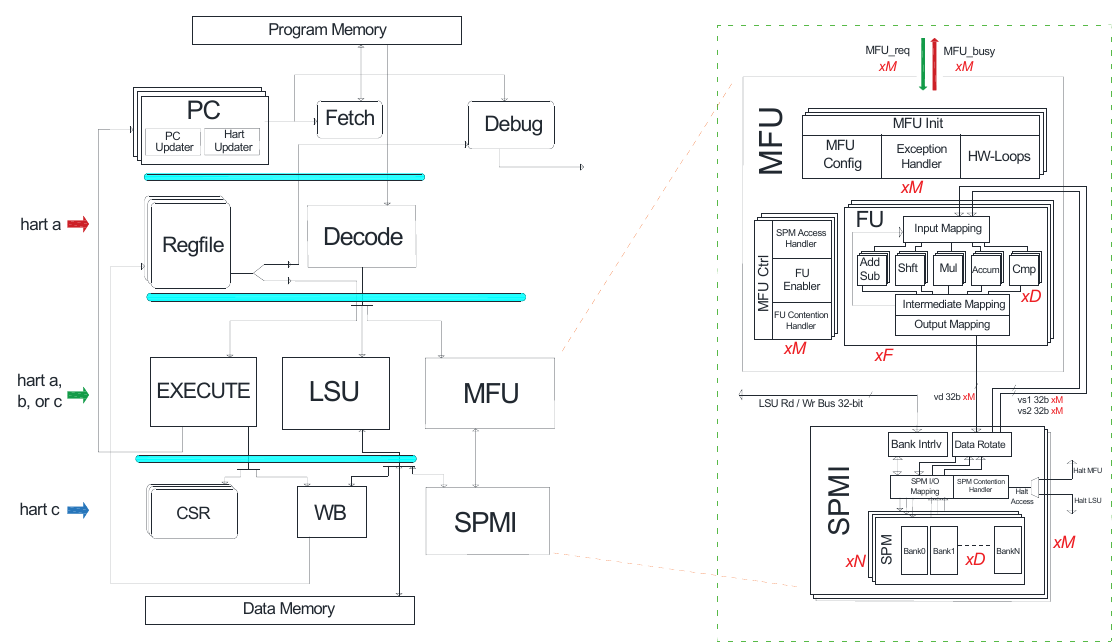
Figure 2. Klessydra T1 core microarchitecture.